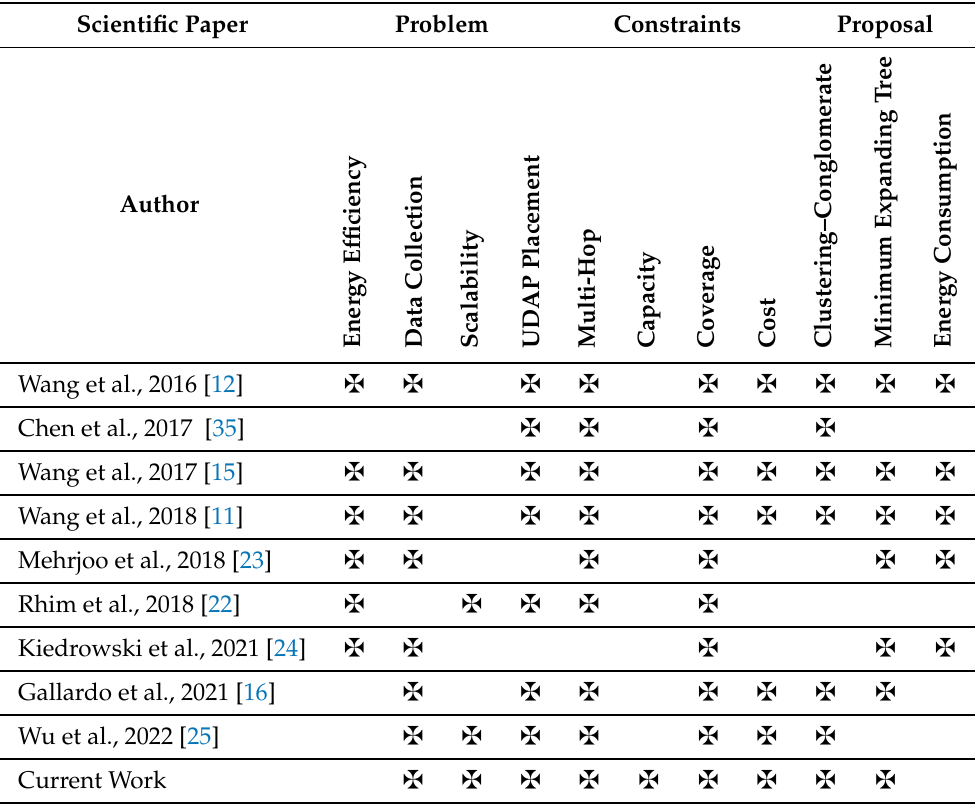
Table 2. Summary of papers related to sizing and georeferenced deployment of UDAPs. Scientific Paper Problem Constraints Proposal